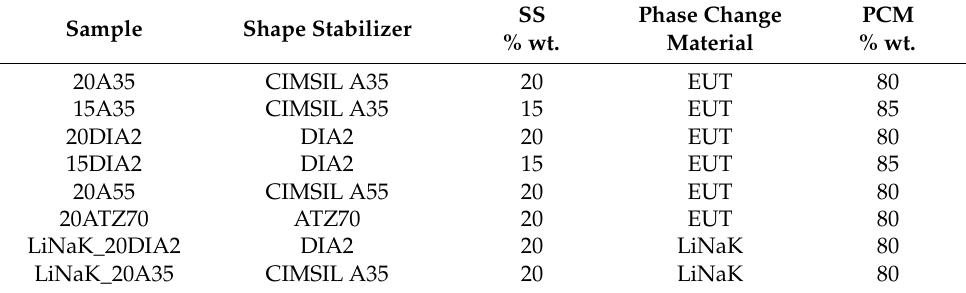
Table 2. List of samples with content and type of SS and PCM.